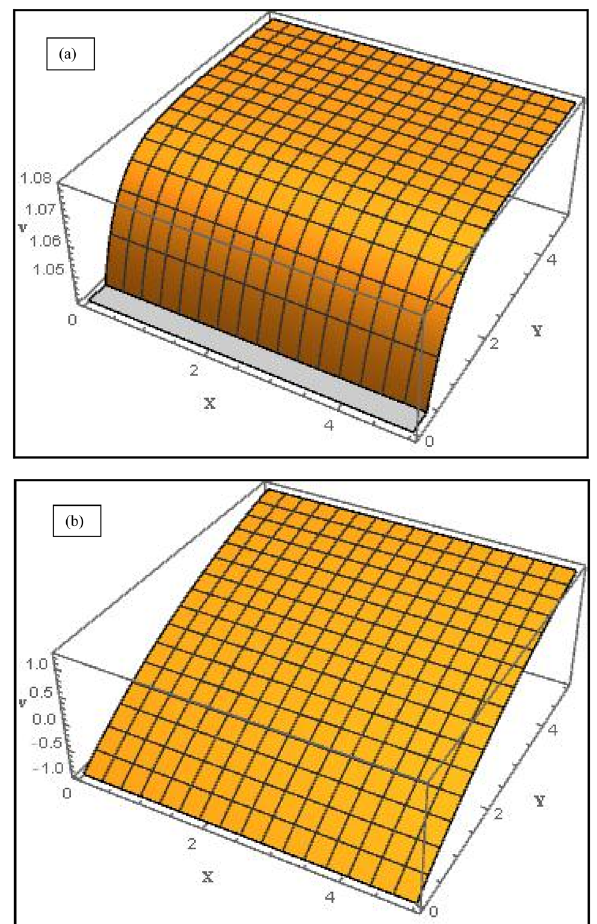
Figure 7. 3-D graph of velocity profile along y -direction for ( a ) suction case ( V C = 1 ) and ( b ) injection case ( V C = − 1 ) with M = Da − 1 = (cid:31) = 1 , S 1 = 1, S 2 = − 1 , ϕ 1 = 0.1, ϕ 2 = 0.04